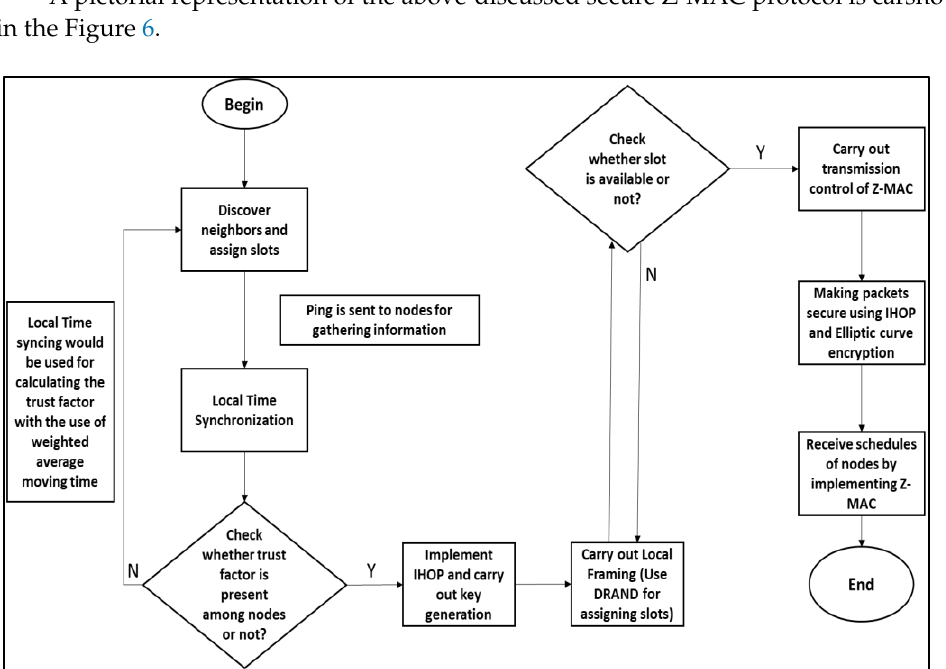
Figure 6. Secure Z-MAC protocol.